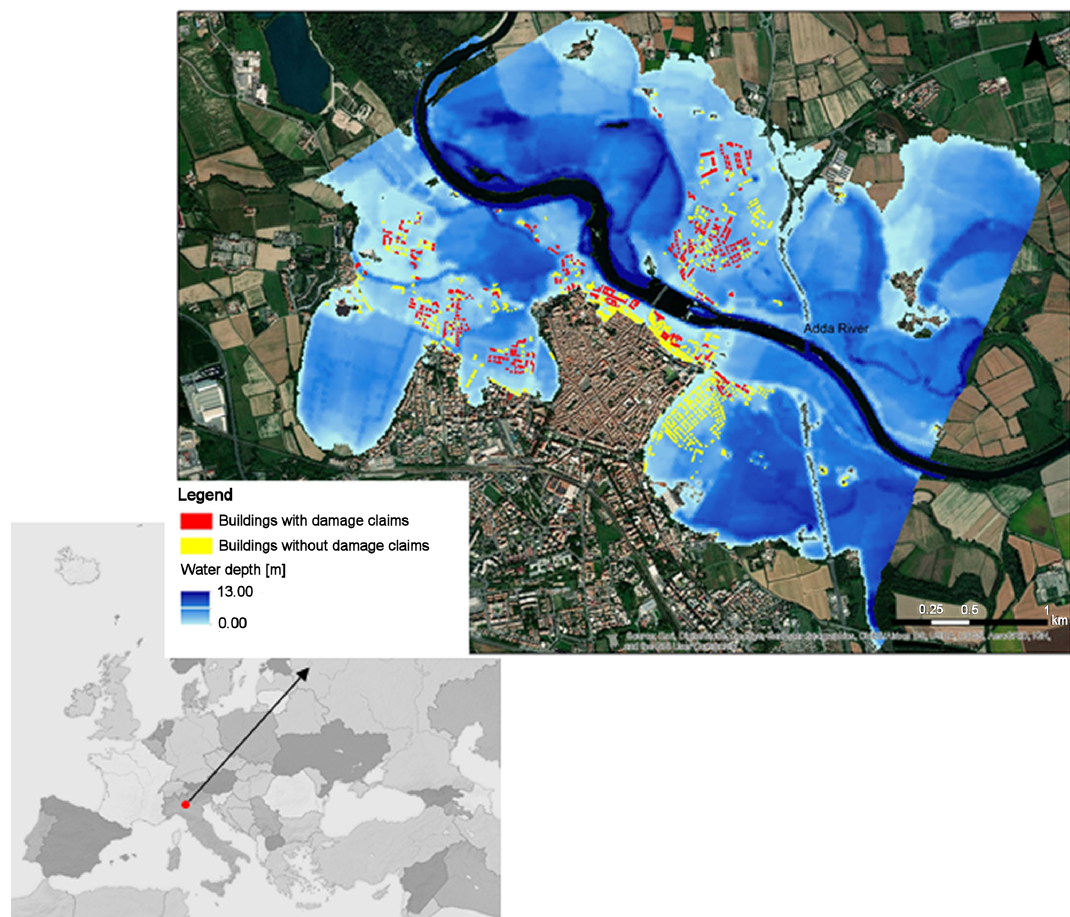
Figure 1. Map of the flooded area and affected buildings (background map from Esri, DigitalGlobe, GeoEye, Earthstar Geographics, CNES/Airbus DS, USDA, USGS, AeroGRID, IGN, and the GIS user